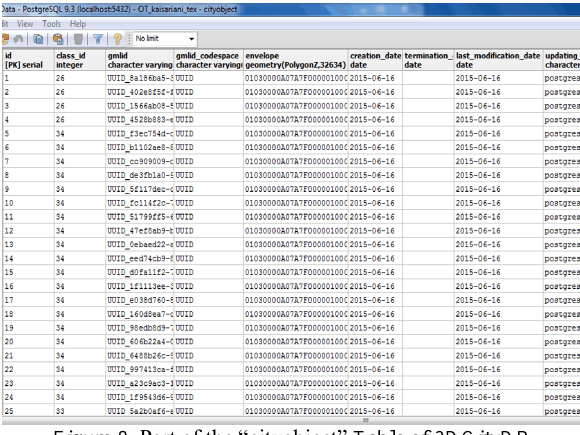
Figure 8. Part of the “cityobject” Table of 3DCityDB